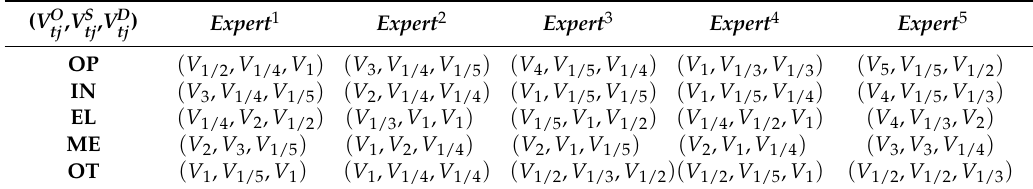
Table 2. Linguistic risk value for the main clusters of failure